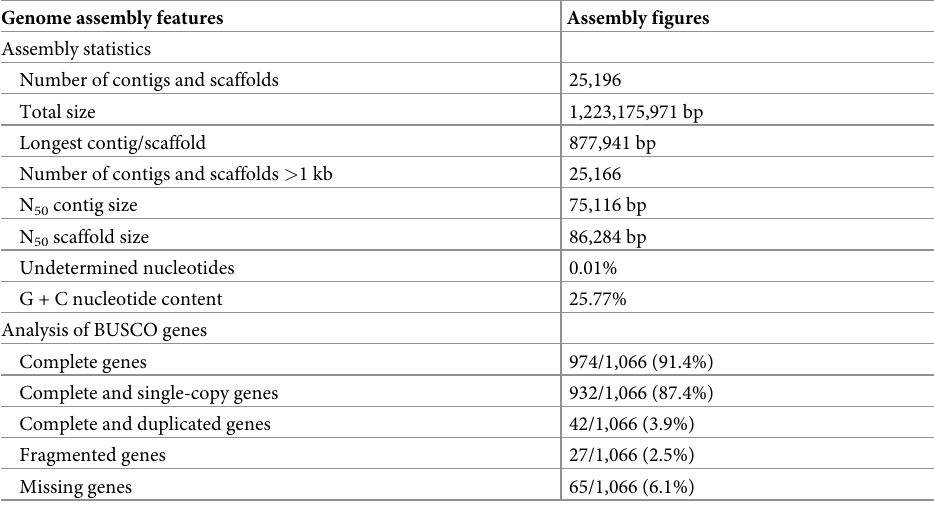
Table 1. Summary information of A . nasatum genome